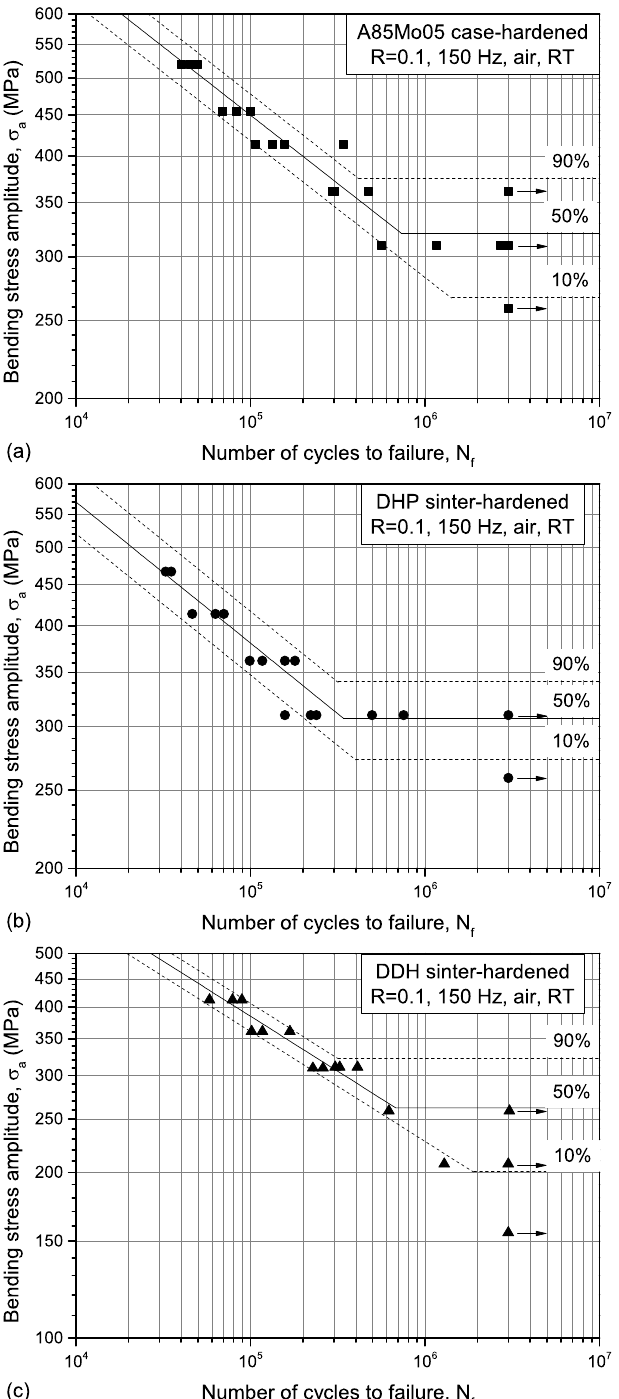
Figure 6. Results of the fatigue tests. ( a ) Case-hardened A85Mo05, ( b ) sinter-hardened DHP, ( c ) sinter-hardened DDH. The run-out samples are indicated by arrows.